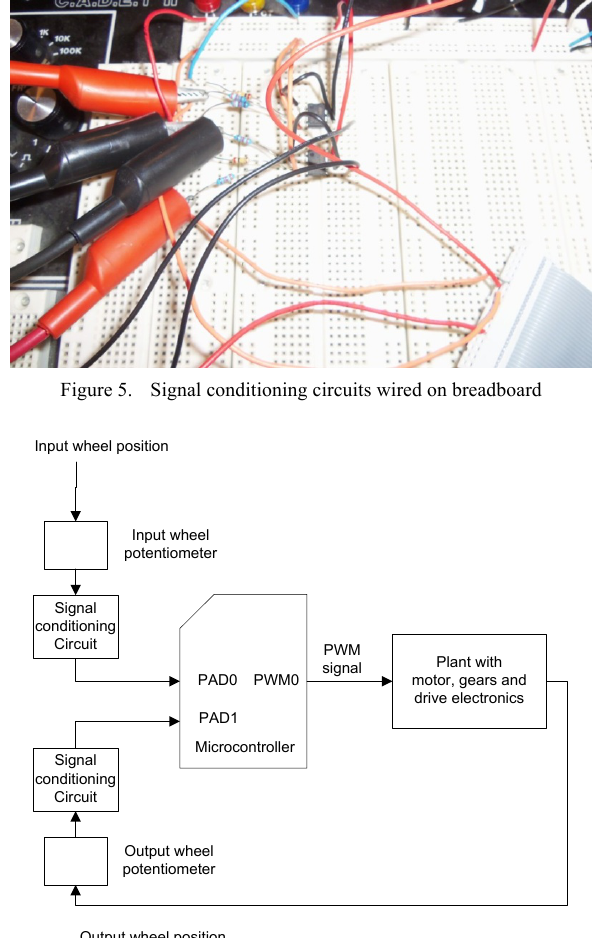
Figure 6. Block diagram of the complete system